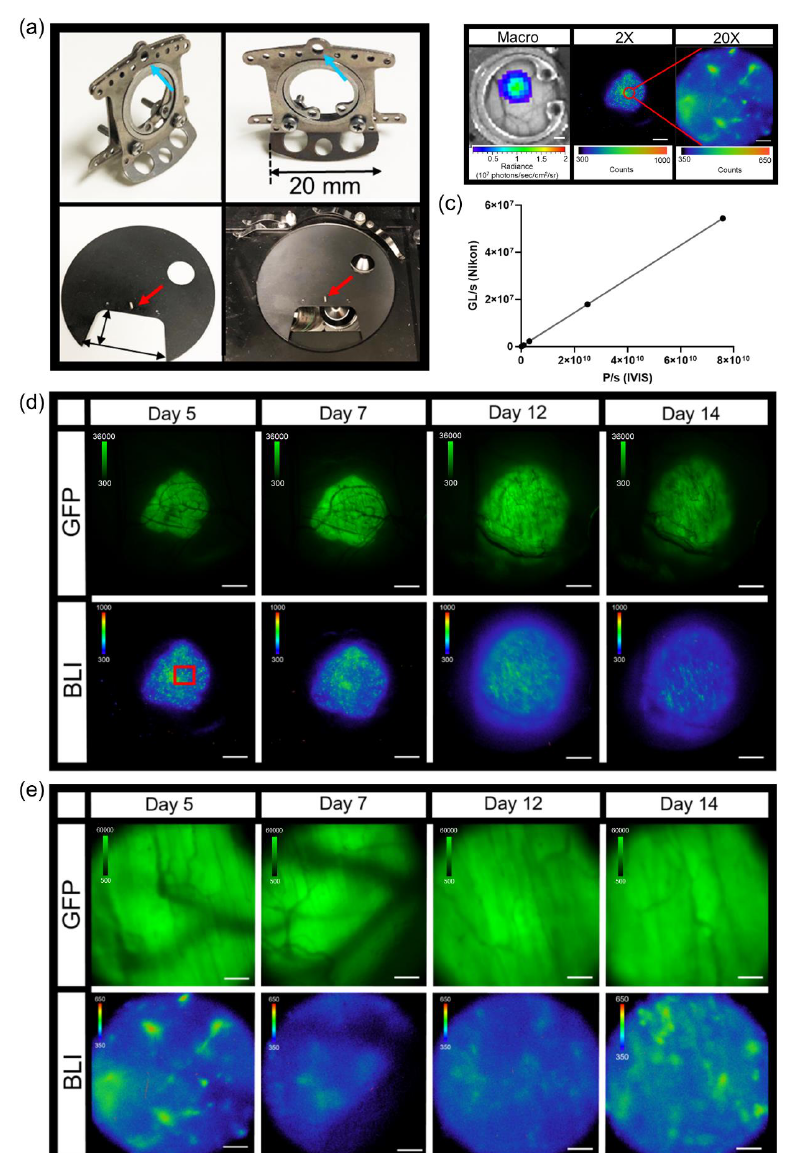
Figure 2. Intravital dorsal skin window chamber bioluminescence and fluorescence imaging. ( a ) Modified skin window chamber implant where front plate flange was shorted to 20 mm (top photos) and custom imaging stage insert (bottom photos; 11 cm diameter insert with a 5.5 cm × 3 cm cutout for the animal to lay flat). A pin protruding perpendicular to the custom imaging stage insert (red arrow) fits into the window chamber implant (blue arrow) to further lock the animal in place during imaging. ( b ) Representative bioluminescence images of B16F10 κB5-FLuc GFP tumors in skin window chamber-bearing animals using the macro-imaging system (macro, scale bar represents 1000 µ m) and the microscopy system at 2X (5 min acquisition, open filter, scale bar represents 1000 µ m) and 20X (10 min acquisition, open filter, scale bar represents 100 µ m) where the red circle on the 2X image indicates a magnified area. ( c ) Linearity analysis between the macro-imaging system (IVIS) and micro-imaging system (Nikon); the correlation was measured at 1 ( p < 0.0001) using n = 5 images where data were expressed as mean ± s.e.m. (error bars fall within the data point). Representative in vivo microscopic imaging over time of B16F10 κ B5-FLuc GFP reporter tumor growth wherein GFP monitors B16F10 tumor growth and BLI monitors FLuc bioluminescence indicative of transcriptional activation of NF- κ B at ( d ) 2X magnification (GFP cube, 500 ms; BLI, 5 min acquisition, open filter, scale bar represents 1000 µ m, red box is corresponding area imaged at 20X) and ( e ) 20X magnification (GFP cube, 20 ms; BLI, 10 min acquisition, open filter, scale bar represents 100 µ